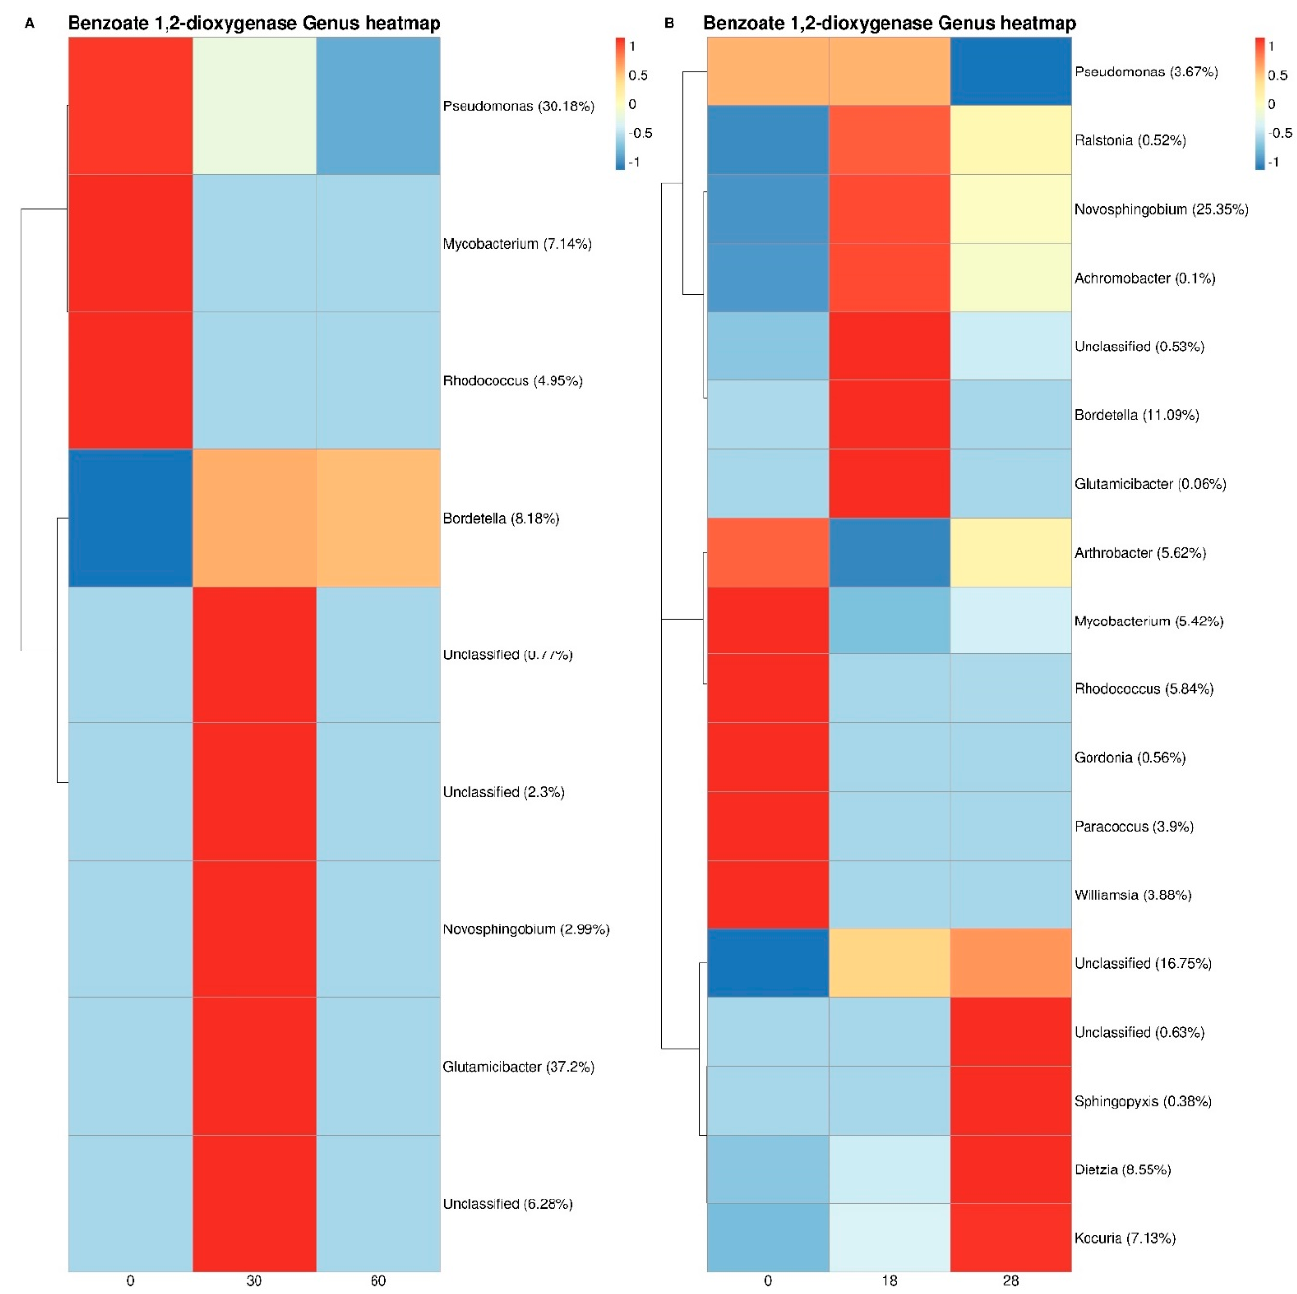
Figure 9. Functional heatmap for benzoate 1,2- dioxygenase at genus level. Functional heatmap showing SMS community ( A ) and Lambertella sp. MUT 5852 community ( B ), genus contribution to benzoate 1,2-dioxygenase (EC:1.14.12.10). Percentages reported near genus names represent the relative abundance of the sum of contribution of that genus per sample, against the total sum of contributions: a cut-off value of 0.005% was chosen. Hierarchical clustering was performed on rows by Pearson correlation, based on Euclidean distance. In order to show variation, a colour scheme that represents row-wise Z-scores of per genus contributions per sample was chosen. For this colour scheme, a Z value of 0 matches the reported percentage near the genus contributor.